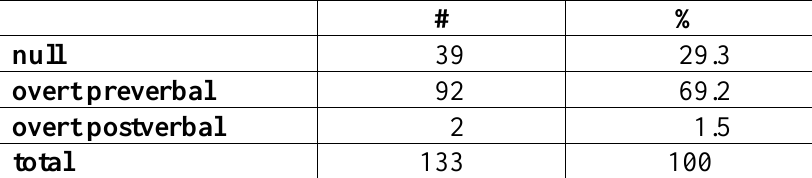
Table (14): Nature and positioning of subject pronouns in direct non-cleft yes/no -